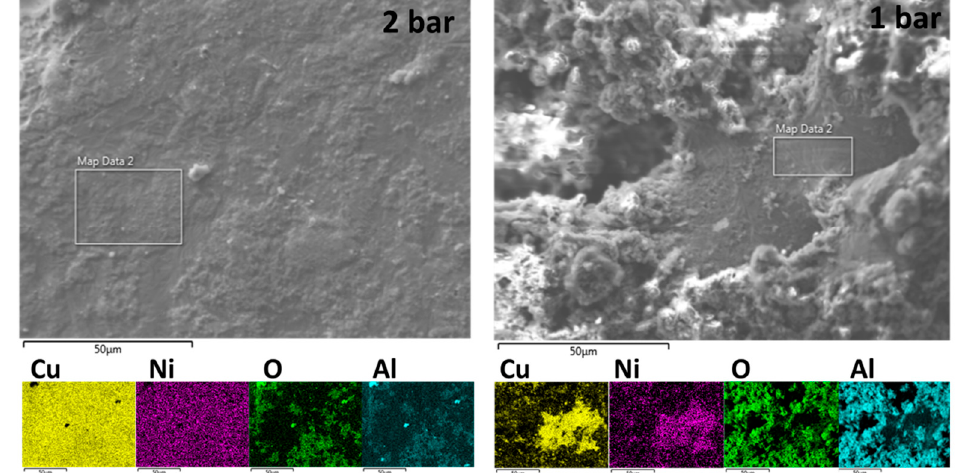
Figure 3. Surface appearance and elemental distribution maps of Cu, Ni, O, and Al determined using SEM-EDS on sample with nominal content of 3 wt.% Ni at relative pressures indicated in the images.